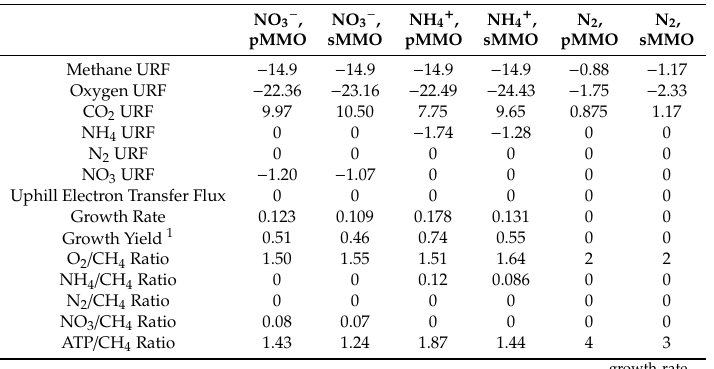
Table 1. In silico uptake rates, growth predictions and molar ratios for iMsOB3b in di ff erent environmental conditions. URF refers uptake rate flux. pMMO is active in copper-added medium while sMMO is active in copper-free medium. Growth rates are in h − 1 units, flux values are in mmol gDCW − 1 h − 1 units. NO 3 − , NO 3 − , NH 4 + , NH 4 + , N 2 , N 2 , pMMO sMMO pMMO sMMO pMMO sMMO Methane